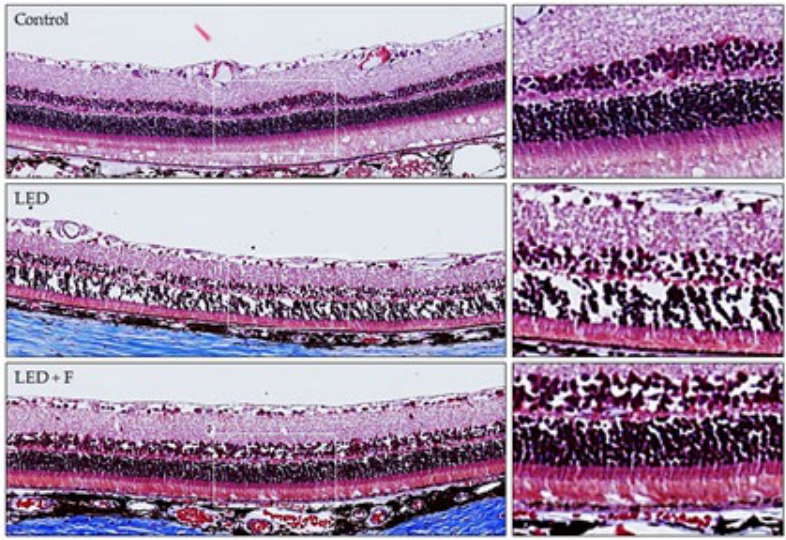
Figure 2. Retinal structure from control rats, rats exposed to LED Screen (LED-S), and rats exposed to LED screen with a protective filter